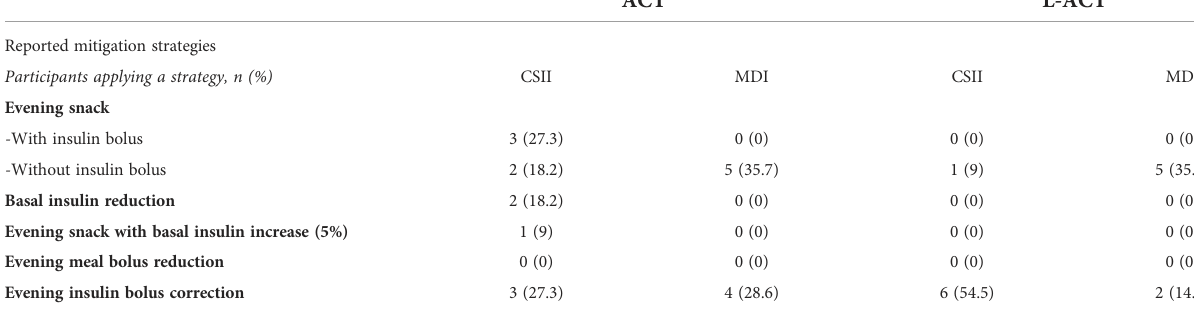
TABLE 4 Participants reporting mitigation strategies to reduce the risk of nocturnal